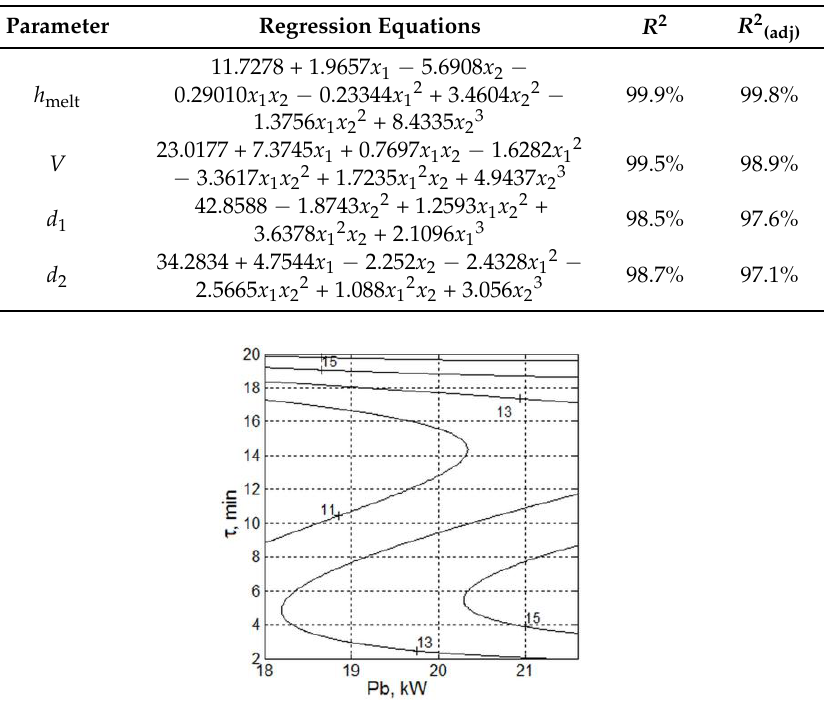
Table 7. Regression models for the molten pool height h melt , the molten pool volume V , and the diameters d 1 and d 2 of the liquid pool ellipse at the top sample surface.